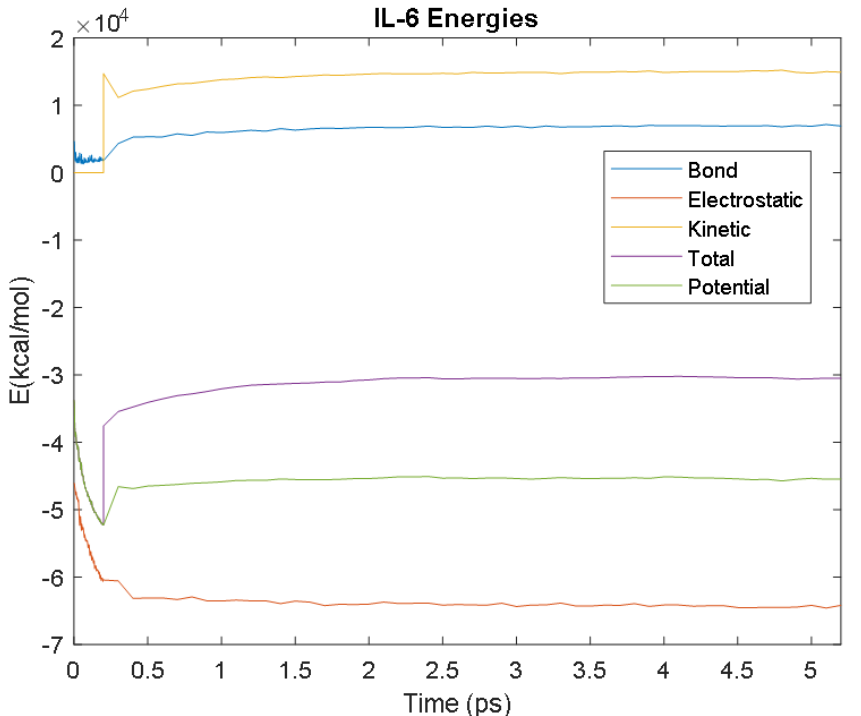
Figure 25. A plot of IL-6’s bond, electrostatic, kinetic, total, and potential energies over 5 ps from its simulation in NAMD.